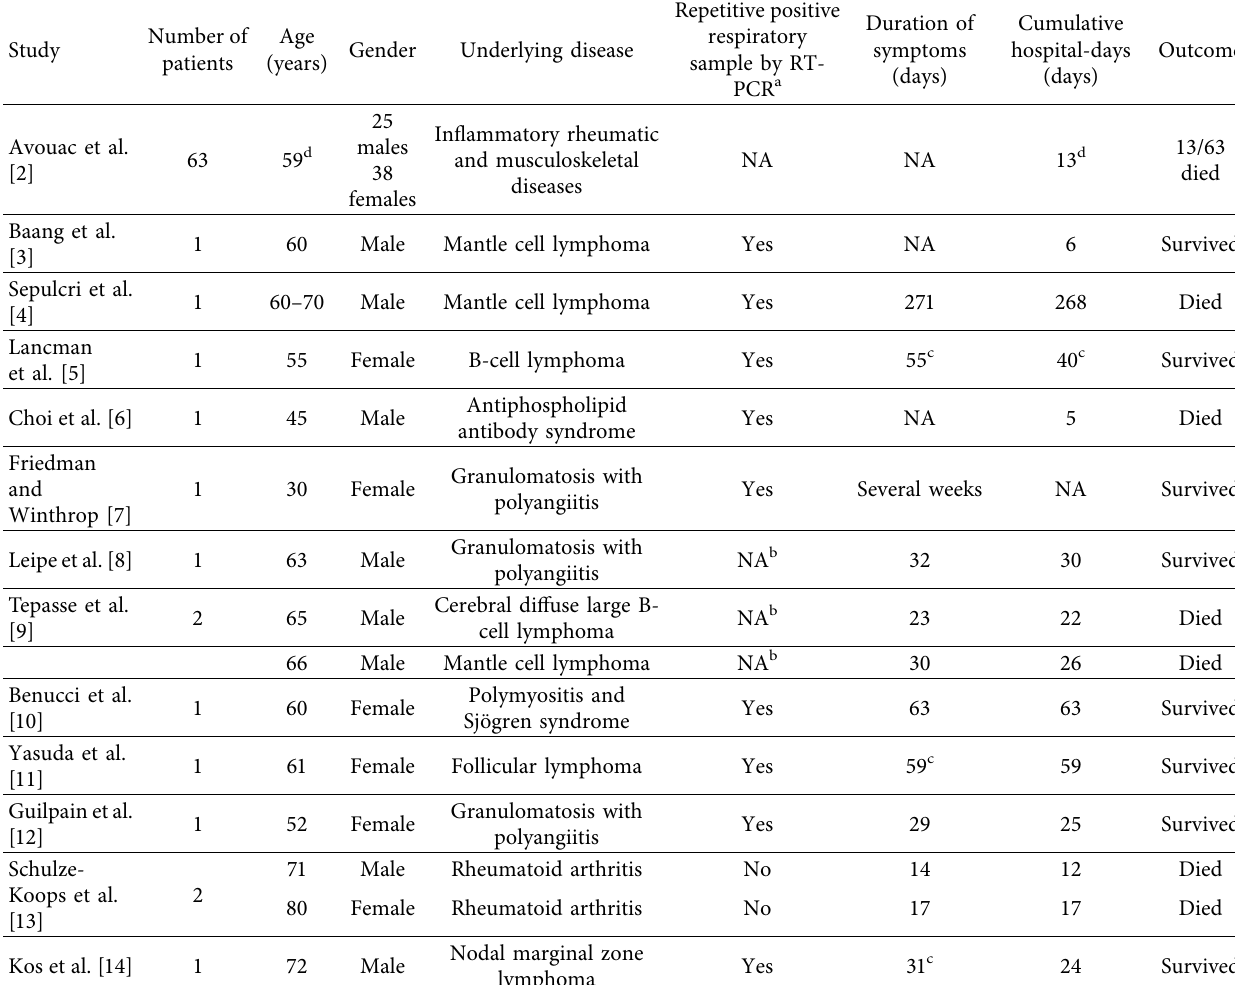
Figure 1: Timeline of cycling threshold (Ct) values during disease course. Table 2: Literature search of patients with COVID-19 and receiving immunosuppressive treatment including